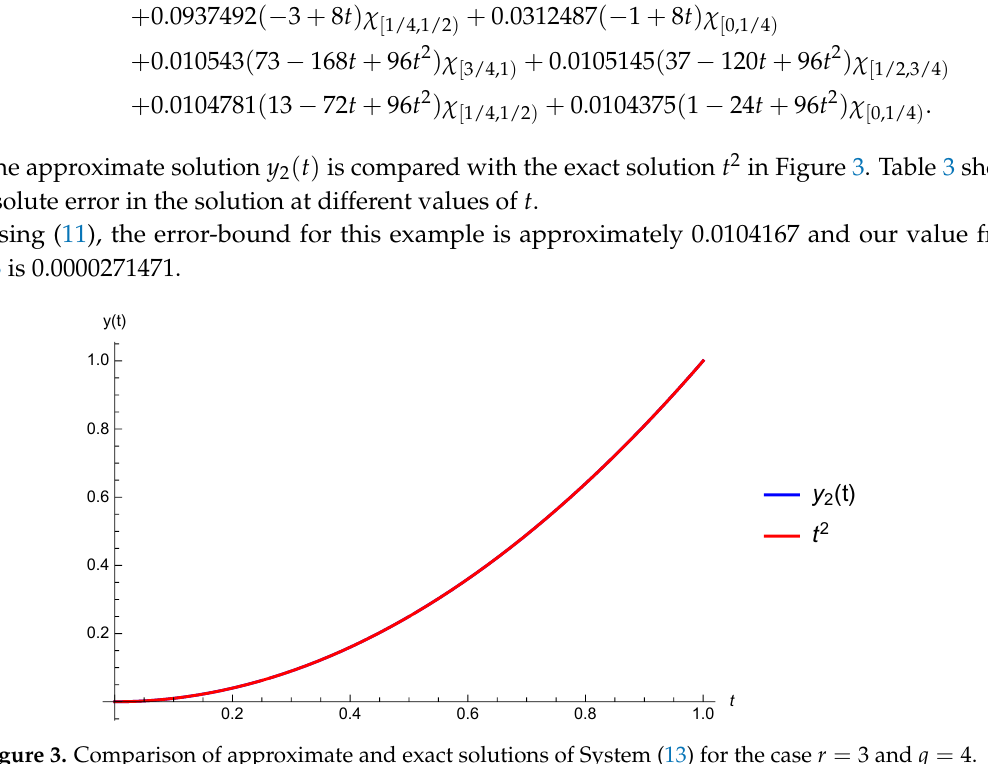
Figure 3. Comparison of approximate and exact solutions of System (13) for the case r = 3 and q =